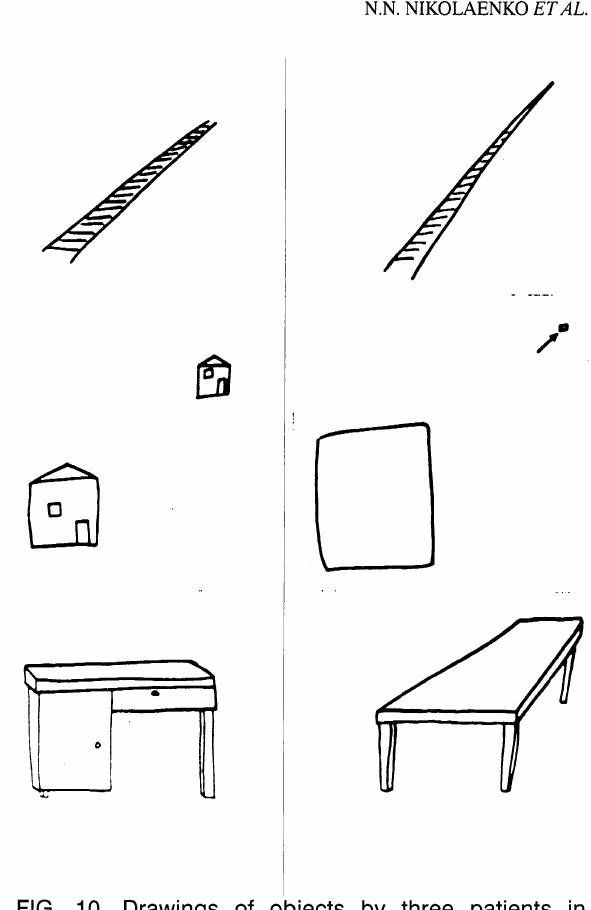
FIG. 10. Drawings of objects by three patients in depressed (left) and manic (right)